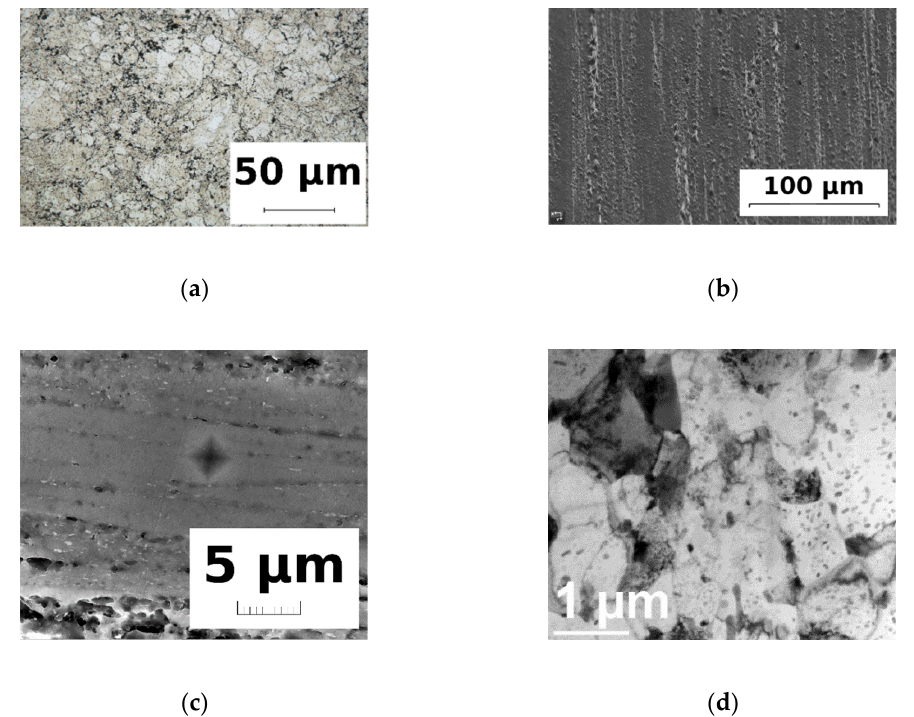
Figure 4. Microstructure of SPS-KOBO extruded AA7075: transverse cross-sectional LM micrograph of etched microstructure ( a ); longitudinal cross-sectional SEM micrographs of unetched microstructure ( b , c ); transverse cross-sectional BF-TEM micrograph of unetched microstructure ( d ).